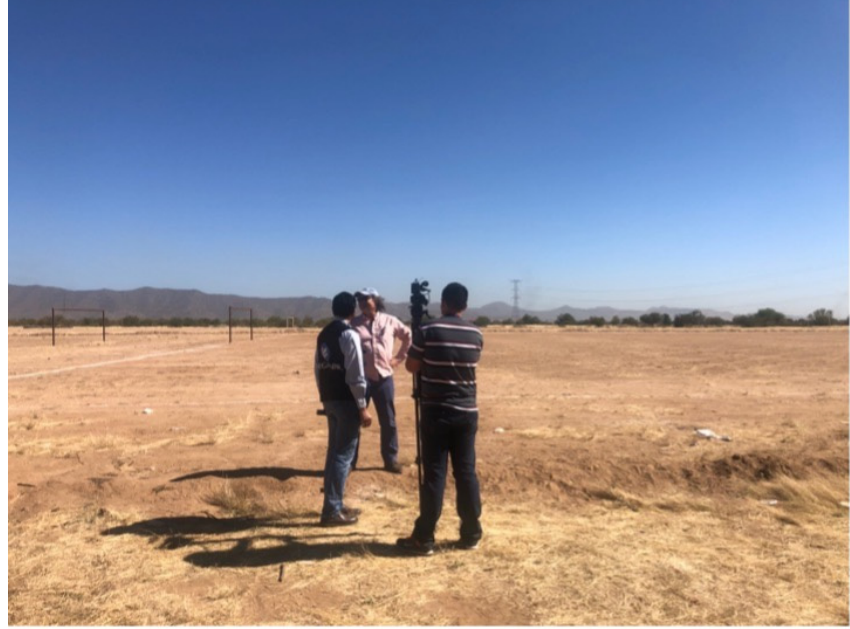
Figure 11. Site visit confirmed the implementation of informal soccer fields (credit: A. Zuniga-Teran).